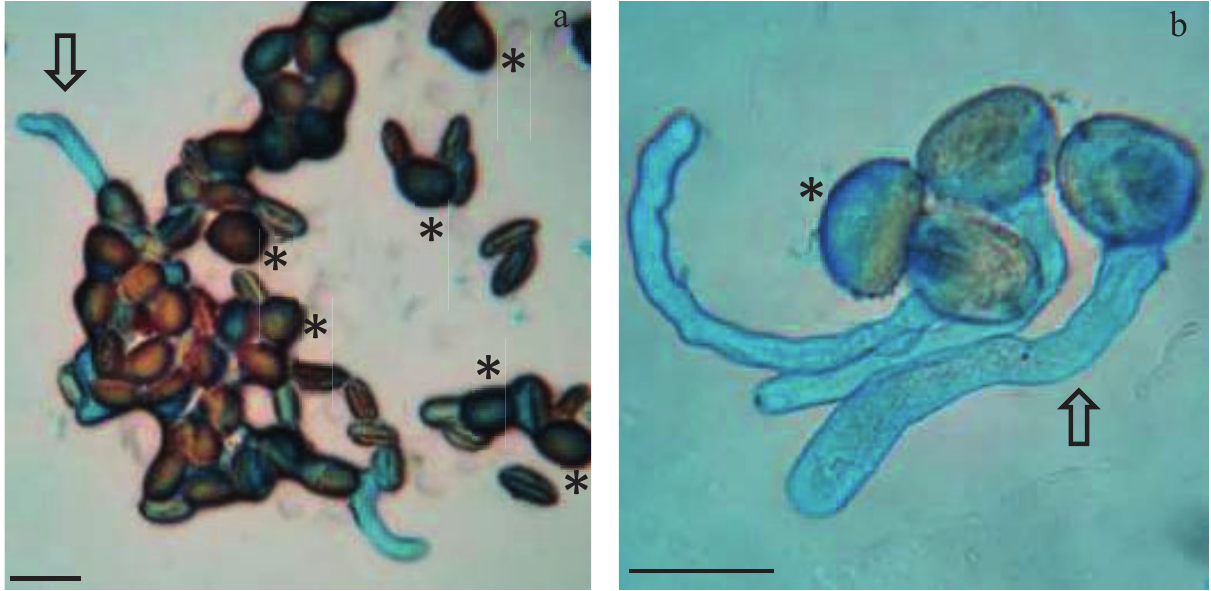
Figure 5. Pollen grains of the experimental hybrid Aloe jucunda x A. vera . Viability test of pollen cultured in vitro with agar-sucrose medi- um. Arrows point to pollen tubes of germinated pollen grains considered viable, while the (*) indicate non-germinated or non-viable pollen grains. Scale bars = 50